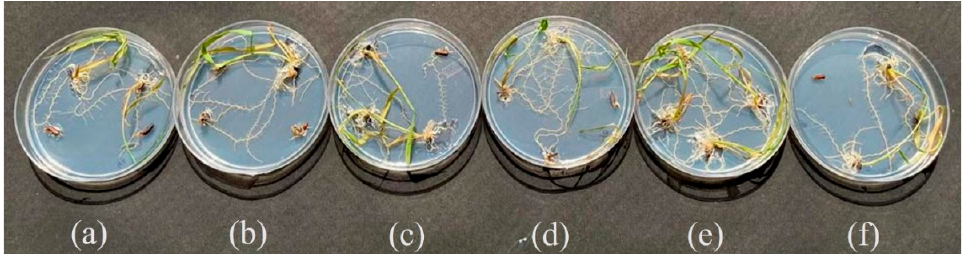
Figure 1. In vitro germination of AgNPs treated black rice seeds showing ( a ) control, ( b ) 20 ppm, ( c ) 40 ppm, ( d ) 60 ppm, ( e ) 80 ppm, and ( f ) 100 ppm.